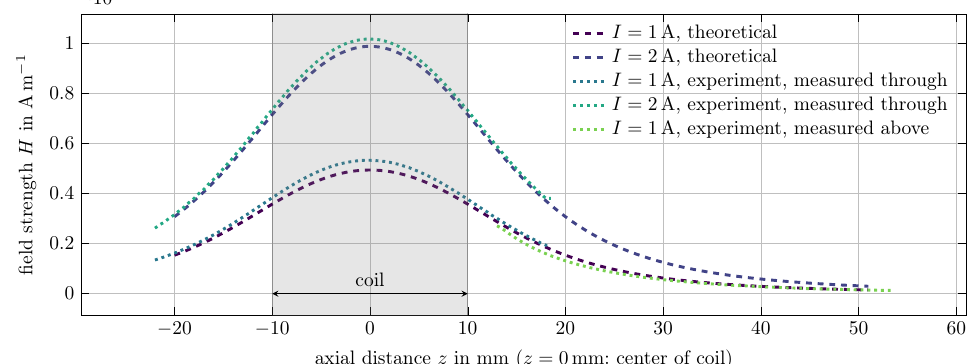
Figure 11. Generated magnetic field at different currents of the magnetization coil with N = 180 of enameled copper wire A cs = 0.28mm 2 , d i = 27mm, d o = 27mm and a coil height h =